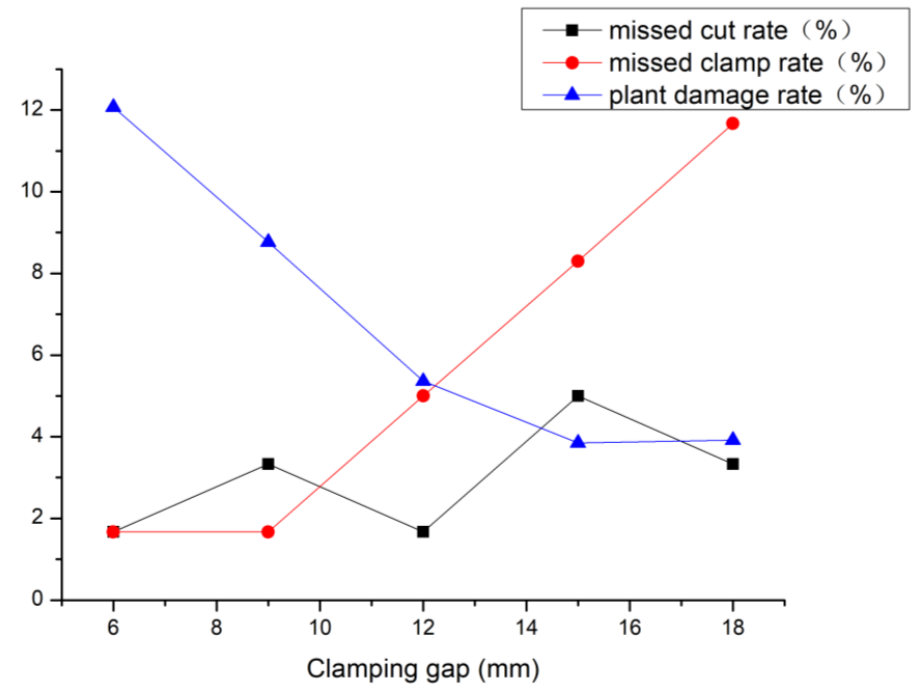
Figure 15. Effect of clamping gap on harvesting performance.